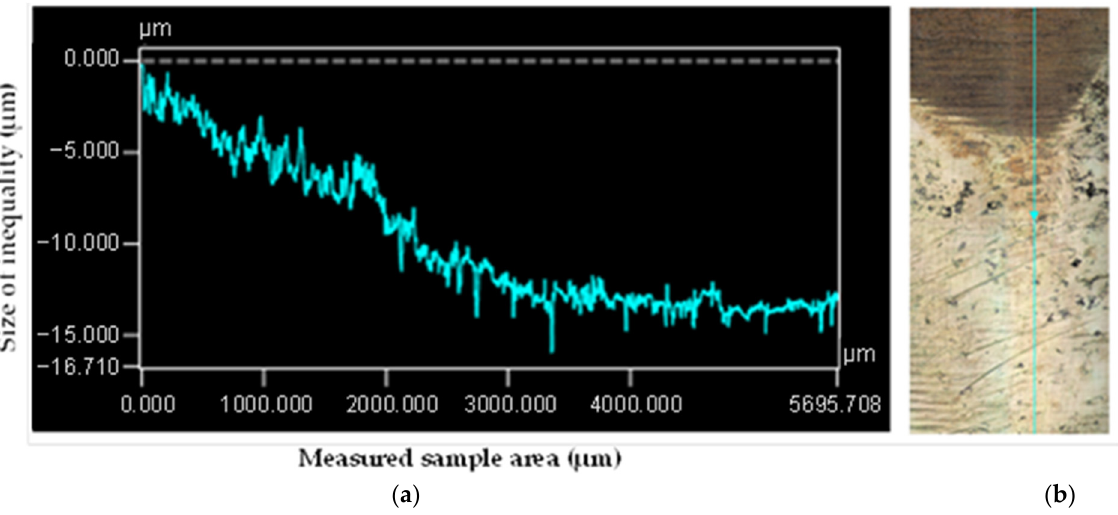
Figure 10. Roughness profile of the exhaust cam surface on the second cylinder: ( a ) measured values and ( b ) laser trajectory at the measuring point. and ( b ) laser trajectory at the measuring